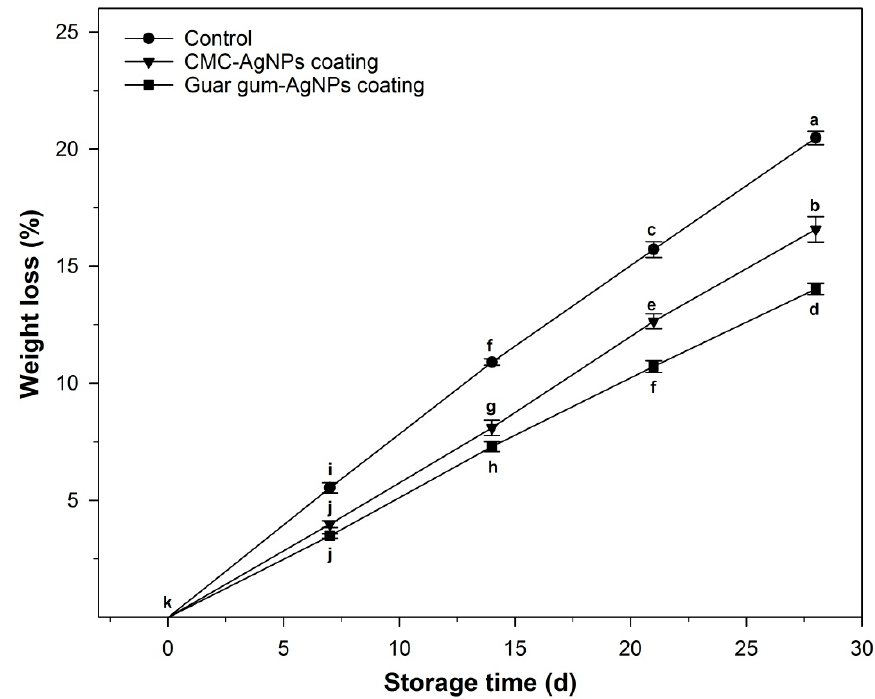
Figure 5. Effect of CMC-AgNPs and guar gum-AgNPs coatings on weight loss of “Seddik” mango fruits stored at 13 °C for 4 weeks. Vertical bars represent the standard error (SE) of means. Means with the same letter are not significantly different according to Duncan’s multiple range test ( α ≤ 0.05).